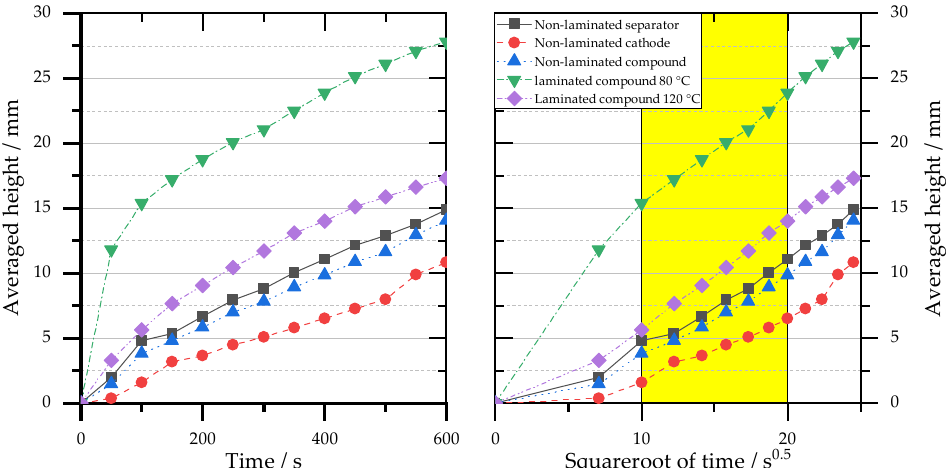
Figure 4. Results of optical measurement of the cathode separator measurement series (i) to (iii). Data points of the time course of mean wetting heights ( left ) and transformed mean heights with evaluation ranges from 10 to 20 s 0.5 ( right ).